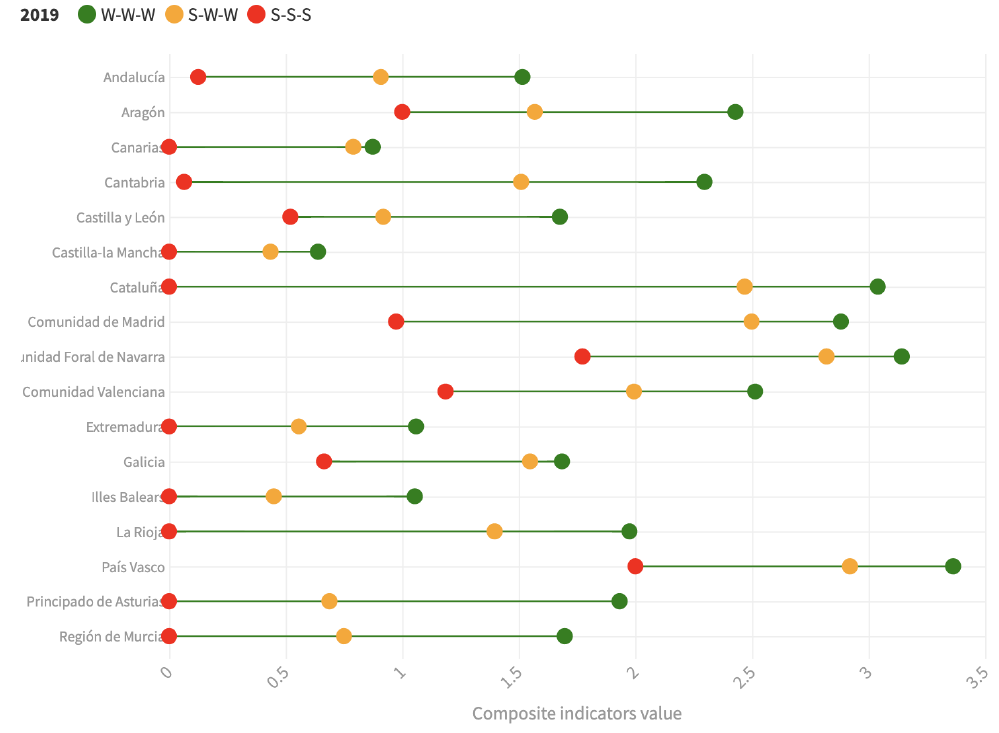
Figure 8. Spain Regions’ innovation performance in 2019 for different levels of compensability: Spanish reference levels.